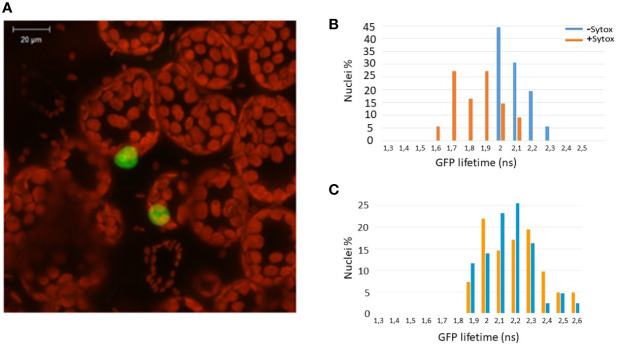
ZBED localizes to the nucleus and binds DNA. The GFP-ZBED fusion protein was transiently expressed in N. benthamiana. (A) GFP-ZBED accumulates in the plant nucleus; DNA binding using FRET/FLIM with or with Sytox (blue and orange bars respectively) with wild-type (B) and a mutated version of ZBED with point mutations of the cysteine to a glycine in each of three BED domains (C).